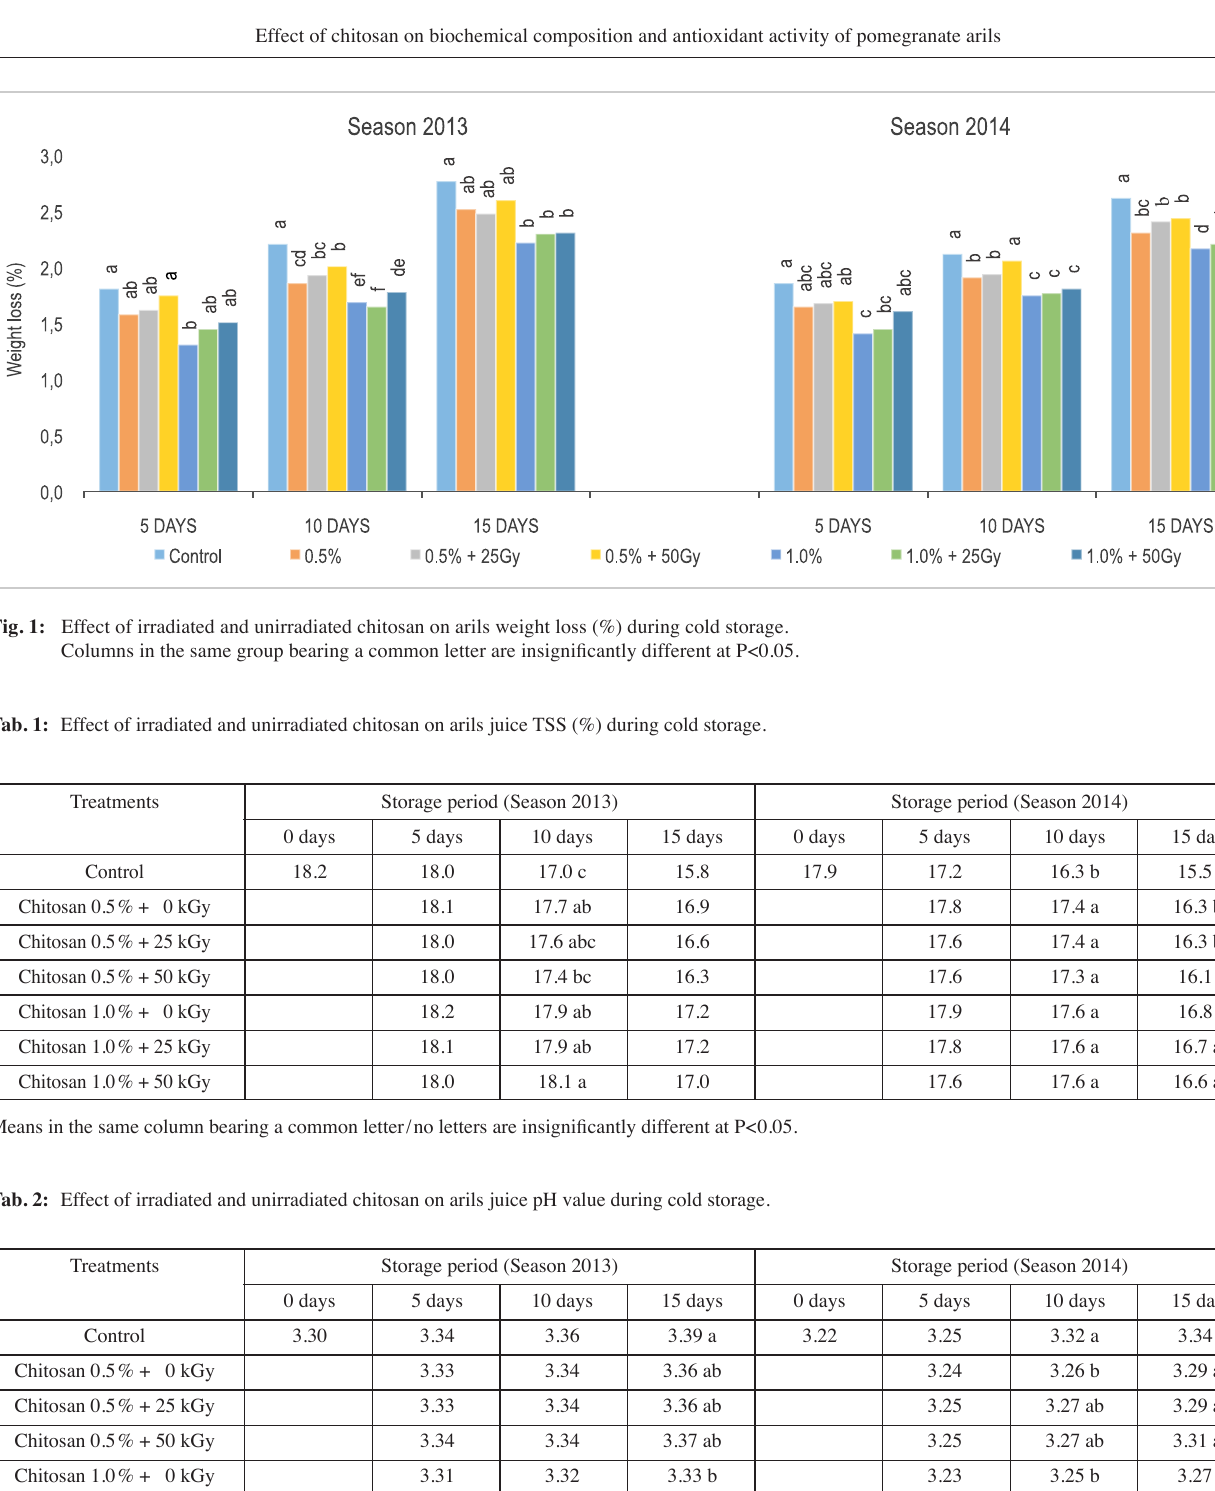
Vitamin C : As shown in Tab. 3, vitamin C reductions were recorded as storage proceeded. It was also found that all chitosan treatments